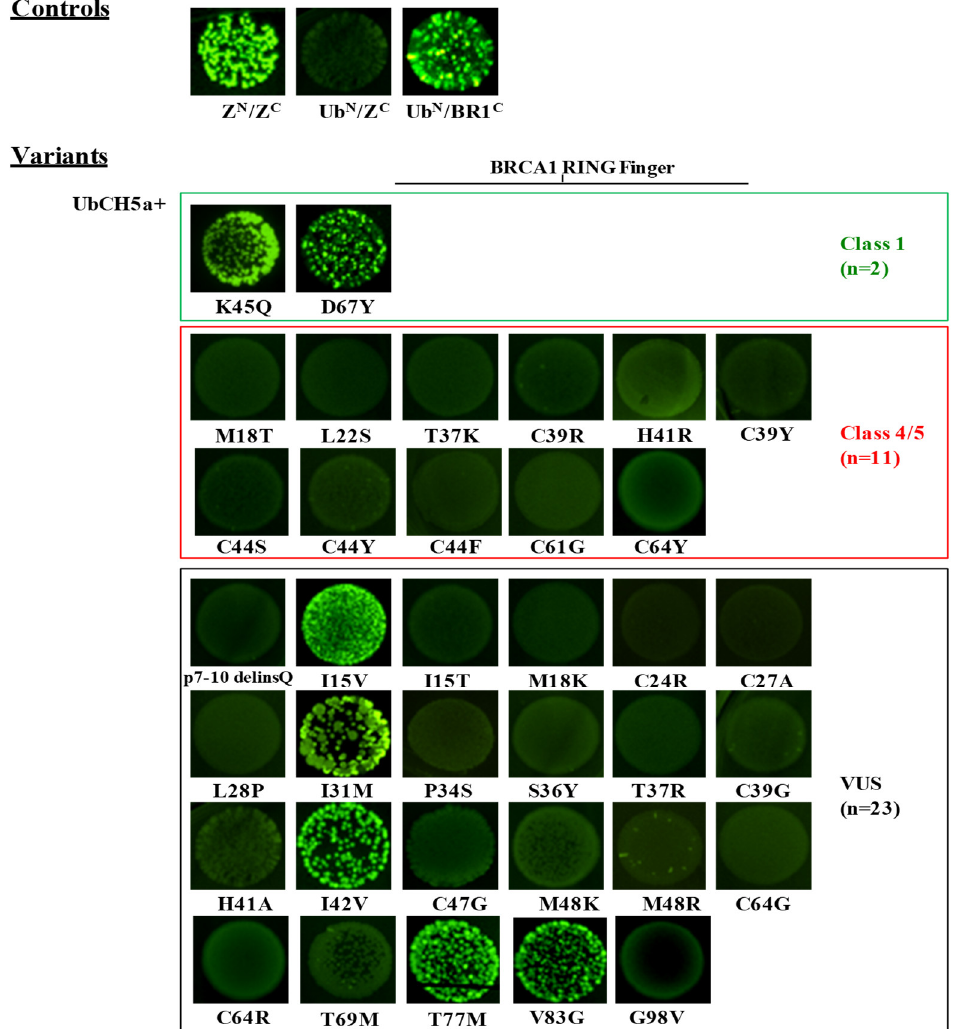
Figure 3. Detection of the UbcH5a/BRCA1 interaction by the GFP-fragment reassembly assay. Fluorescence was assessed after 24 h of growth at 30 °C followed by 2 days of incubation at RT. All pictures were taken with the same setting of digital camera (long-wave UV light, 365 nm). [Z N , H 6 - NfrGFPZ, Z C , ZCfrGFP, Ub N , H 6 -NfrGFPUbcH5a, BR1 C , BRCA1CfrGFP].